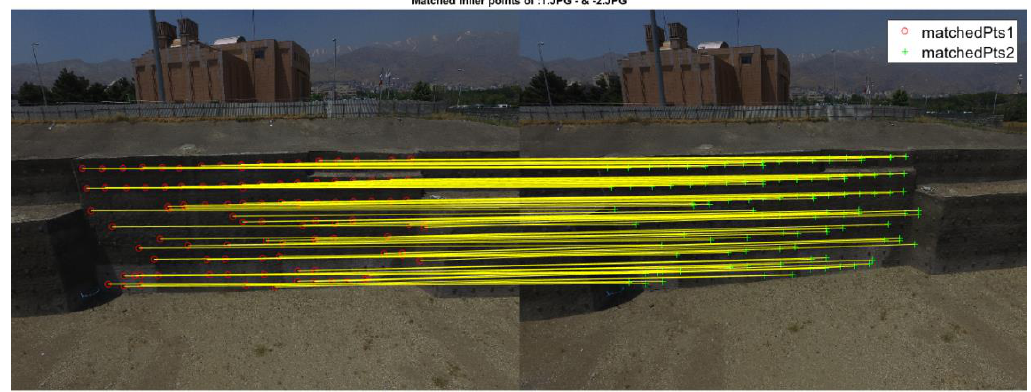
Figure 6. An example of initial correspondence matching between two images, with false correspondences